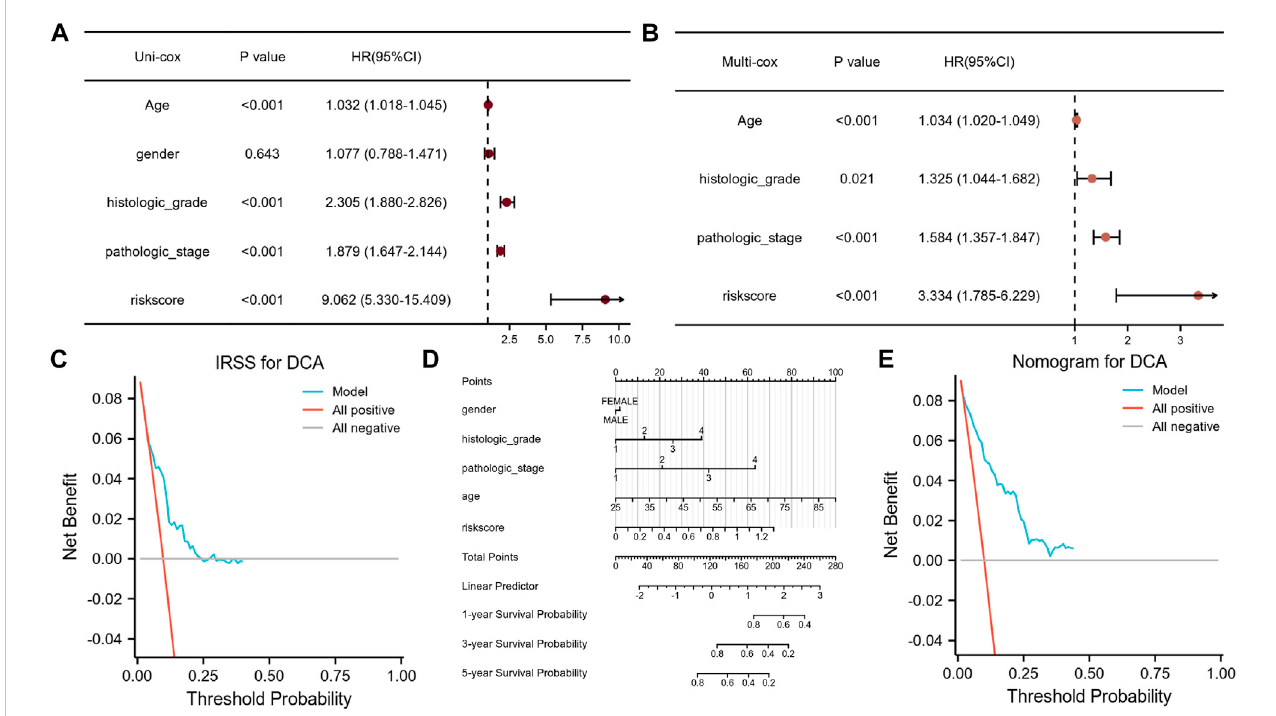
FIGURE 8 Assessment of the IRSS along with establishment and assessment of nomograms. (A) Univariate Cox regression analysis indicated that age, gender, histological grade of the tumor, pathological stage of the tumor, and risk score were correlated with OS in KIRC patients. (B) Multivariate Cox regression analysisindicatedthattheriskscorewascorrelatedwiththeOSinKIRCpatients. (C) Decisioncurveanalysis(DCA)forassessingtheperformanceoftheIRSSin prognostic prediction. (D) 1-, 3-, and 5-year nomograms for predicting OS in patients with KIRC. This nomogram incorporates the following fi ve variables: Age, gender, histological grade of the tumor, pathological stage of the tumor, and IRSS. (E) Decision curve analysis (DCA) for the assessing the performance of the nomogram.